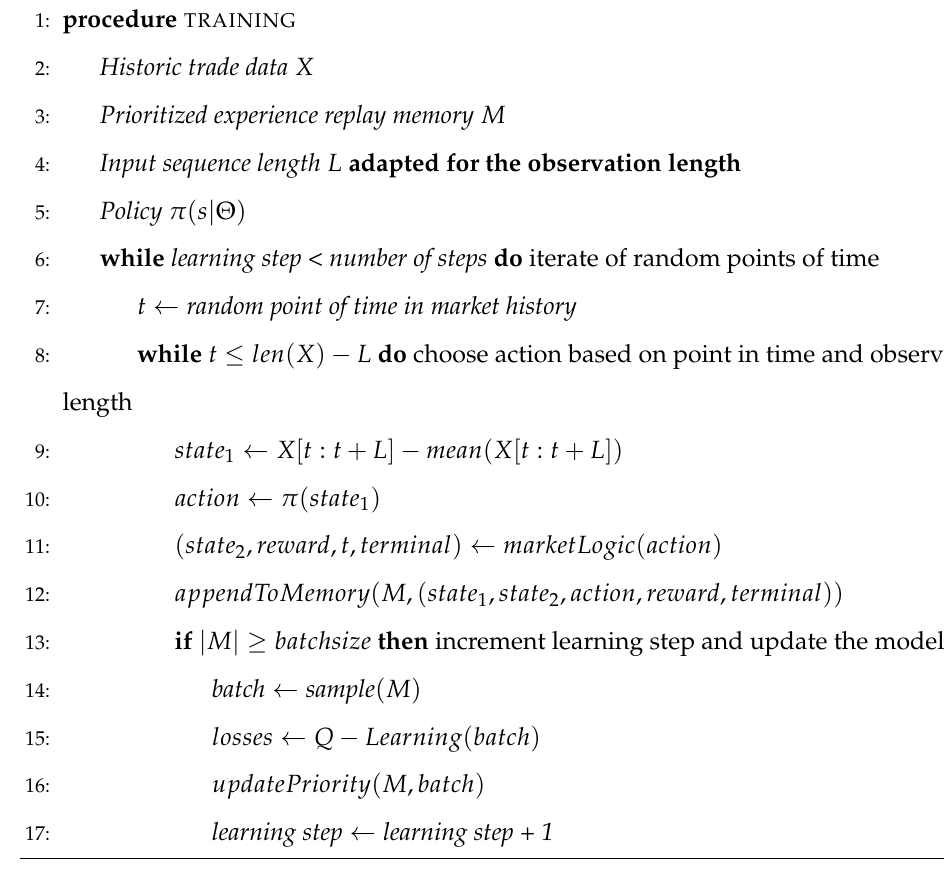
Algorithm A1 Training in Market Simulation